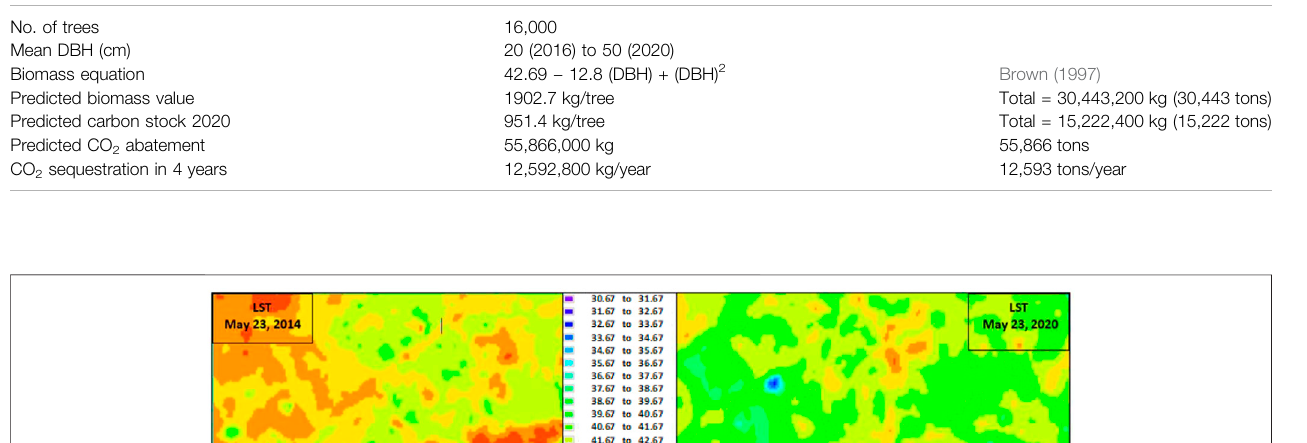
Frontiers in Environmental Science |